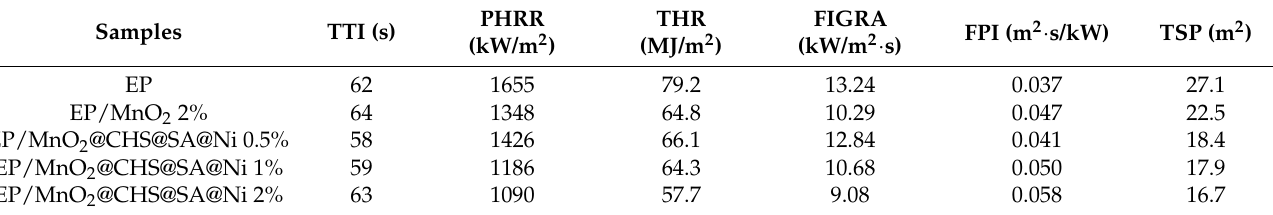
Table 1. Cone calorimeter test results of pristine EP and its